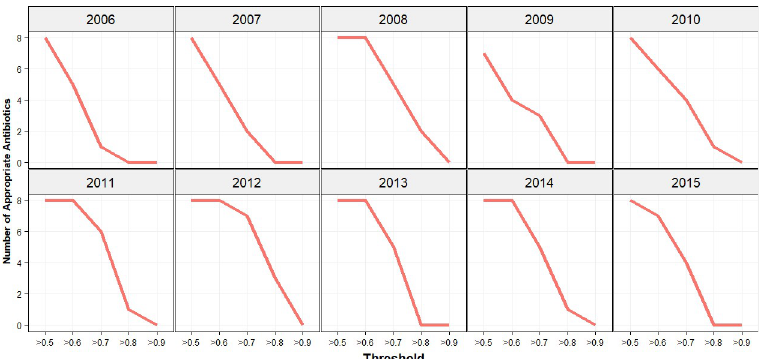
Fig 8. Appropriate antibiotics threshold analysis for combination antibiotic choices. Incremental increases of 0.1 on the threshold to determine appropriate antibiotics for combination agent choices. On y-axis the number of appropriate antibiotics and on the x-axis the threshold value applied on the lower IQR is illustrated. Increase in threshold has gradually declined the number of appropriate antibiotics.